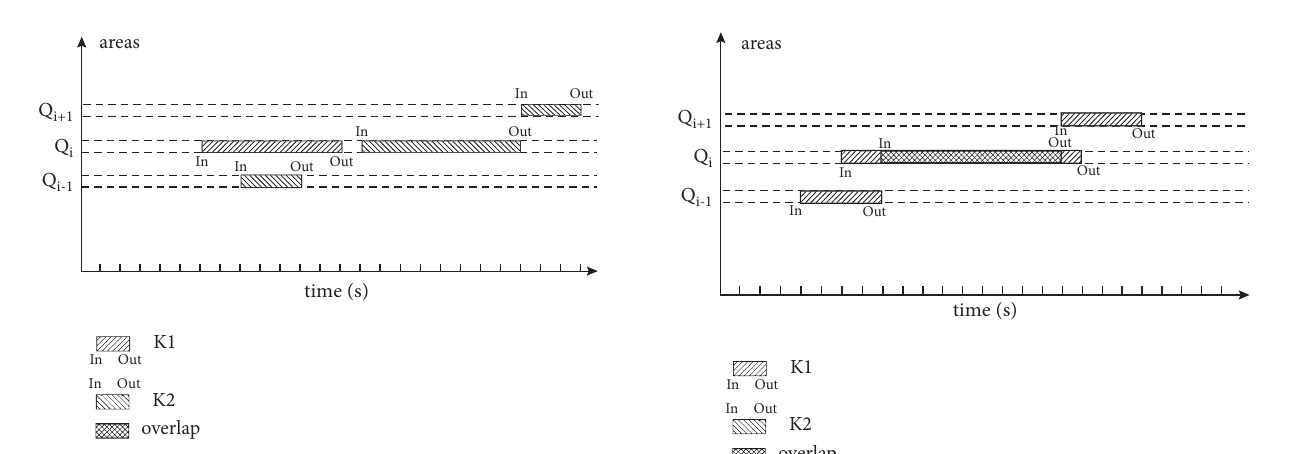
Figure 7: Update the time window for head-to-head conflict.